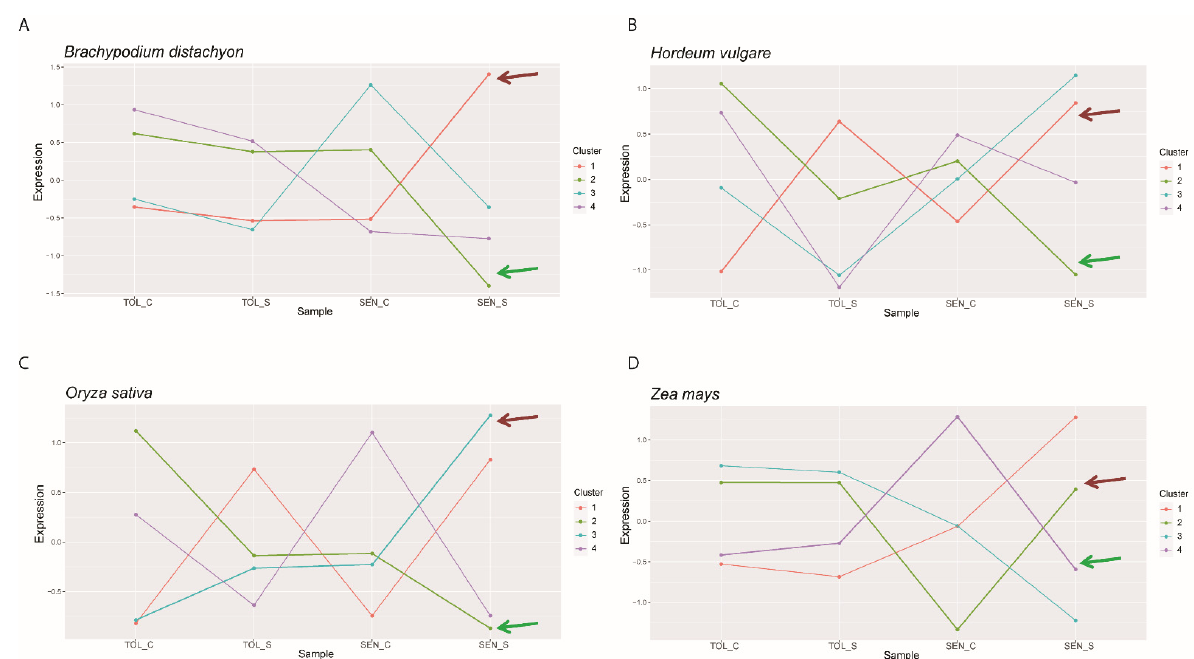
Figure 4. K-means cluster analysis of gene expression of TF-encoding DEGs and CDT genes in the four cereal datasets. Distance matrix for k-means clustering was calculated by Euclidean similarity measurement and using centred Pearson’s correlation as the distance metric, resulting in four gene clusters for each species: B. distachyon ( A ), H. vulgare ( B ), O. sativa ( C ), and Z. mays ( D ). Expression refers to log2+1 normalized TPM values that were then scaled to identify clusters of genes that share similar expression profiles rather than similar expression levels. The lines in the cluster plots represent the centroids in each cluster, around which genes with similar expression profiles are associated. The negatively correlated clusters harbouring SGR genes or photosynthesis-related genes (the genes CA1/PsaO/PsaK/LHCB for Brachypodium, barley, and rice, the genes CA1/PsaO//LHCB for maize) are indicated by brown or green arrows, respectively. TOL_C: gene expression of tolerant genotypes that were used as non-stressed controls in the experiments; TOL_S: gene expression of tolerant genotypes under drought stress; SEN_C: gene expression of sensitive genotypes that were used as non-stressed controls; SEN_S: gene expression of sensitive genotypes under drought stress.